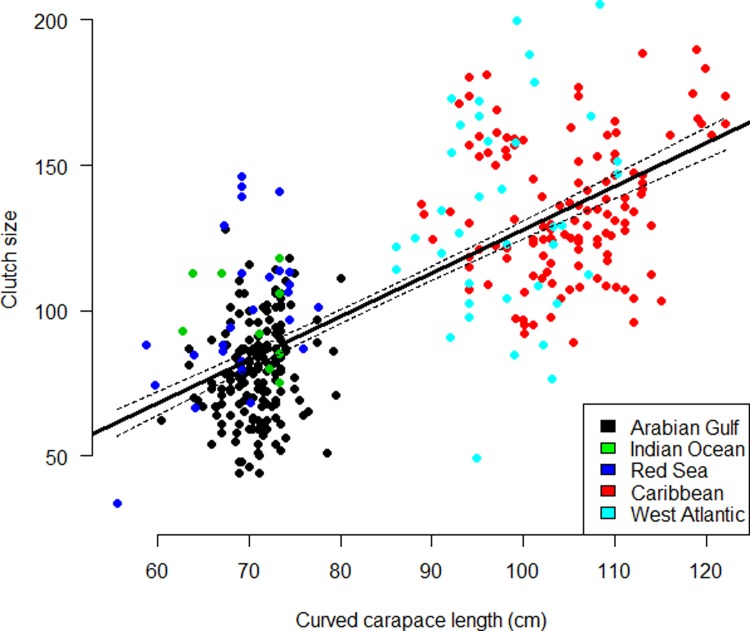
Linear regression of CCL and clutch size using data from different global regions.Significant relationship found (Regression: F4,368 = 64.59; R2 = 0.60; p<0.01). Solid line represents the mean and dotted lines show 95% confidence intervals. Data for the Arabian Gulf was from the present study and Pazira et al. (2016); raw data from the Caribbean was collected from Xavier et al. (2006); Ross (1980) provided data from the Indian Ocean; Red Sea data was from Hirth and Abdel Latif (1980) and West Atlantic data was from Marcovaldi et al. (1999).